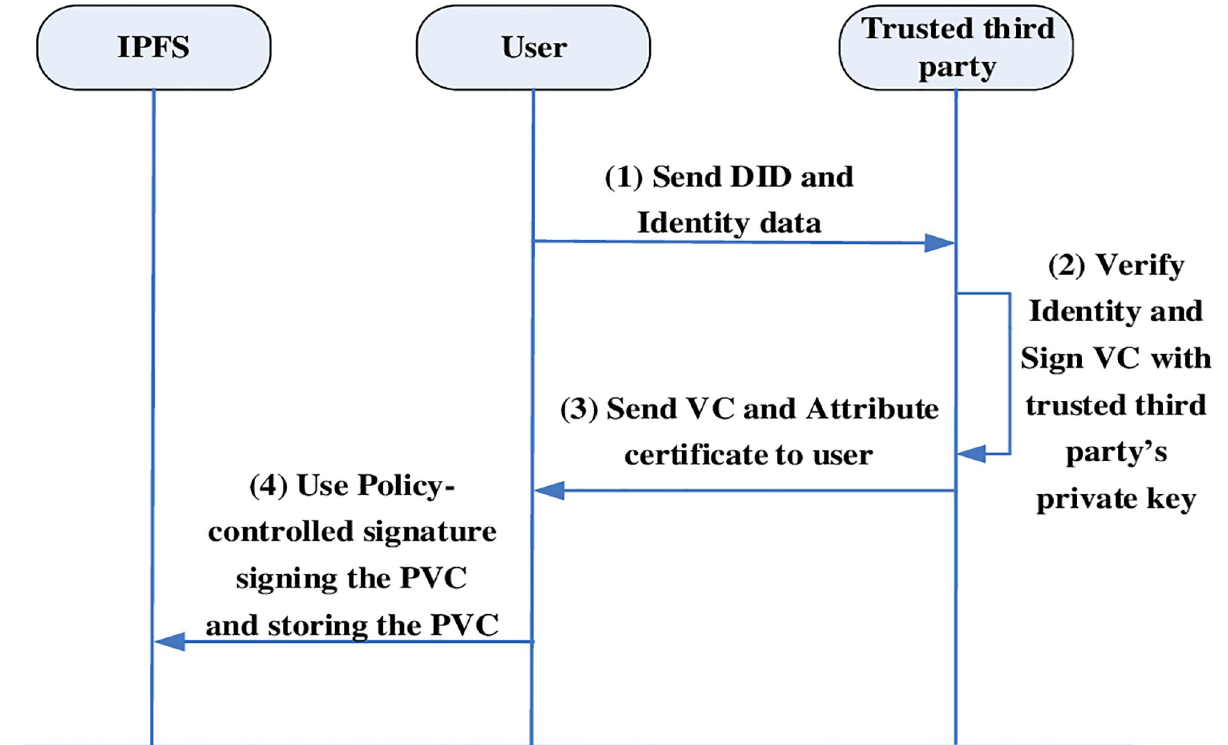
Fig 7. Central domain registration